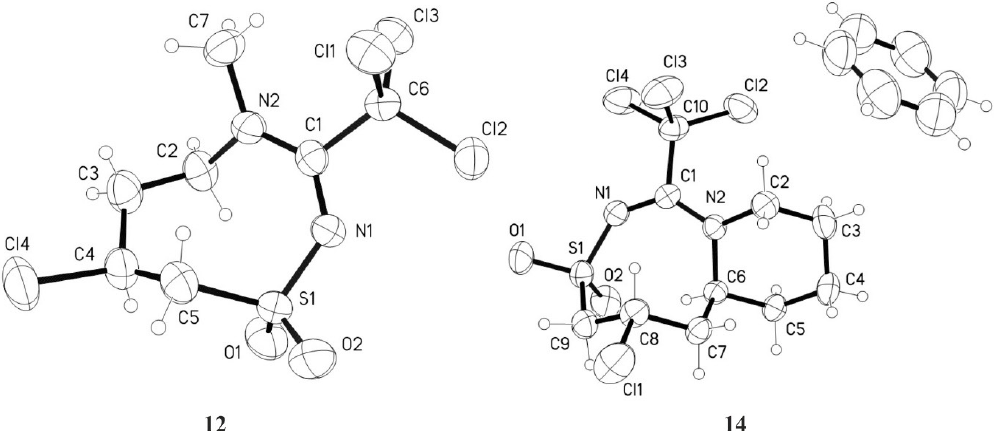
Figure 5. Molecular structure of thiadiazocine dioxides 12 , 14 including thermal displacement ellipses with 50% probability.